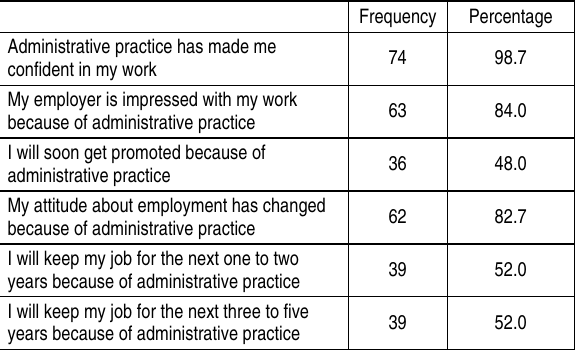
Table 3. Frequency on sustainable employment